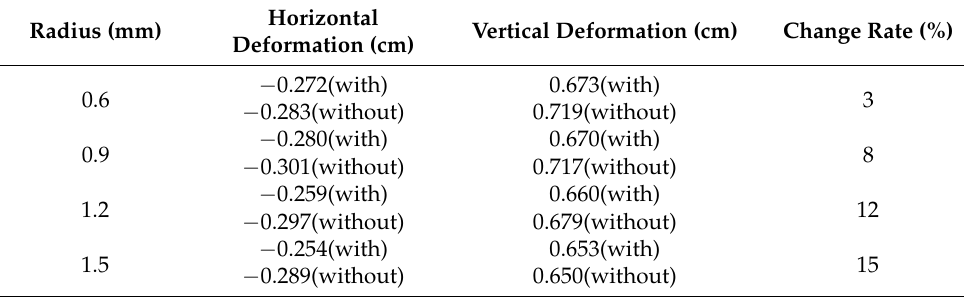
Figure 6. Physical fields of the 1.5 mm model without rings: ( a ) Mises stress field; ( b ) displacement field along the x -direction; ( c ) displacement field along the y-direction.